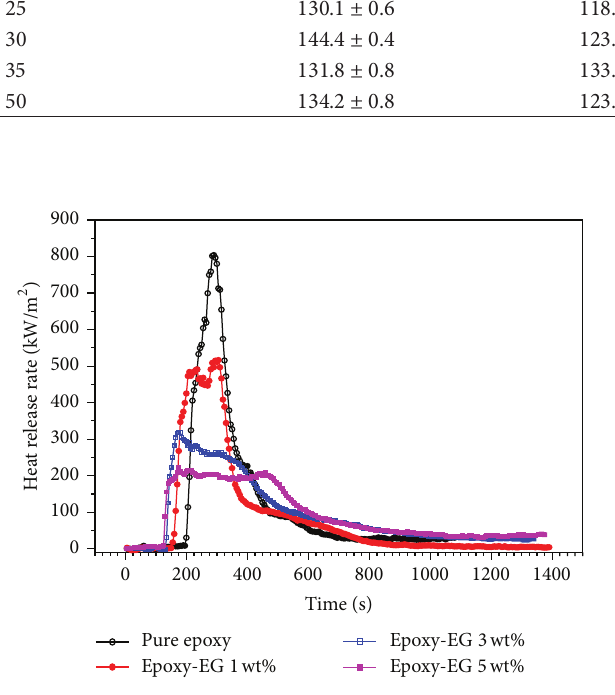
Figure 7: HRR profile of different epoxy-EG compositions at exter- nal heat flux of 25 kWm −2 .